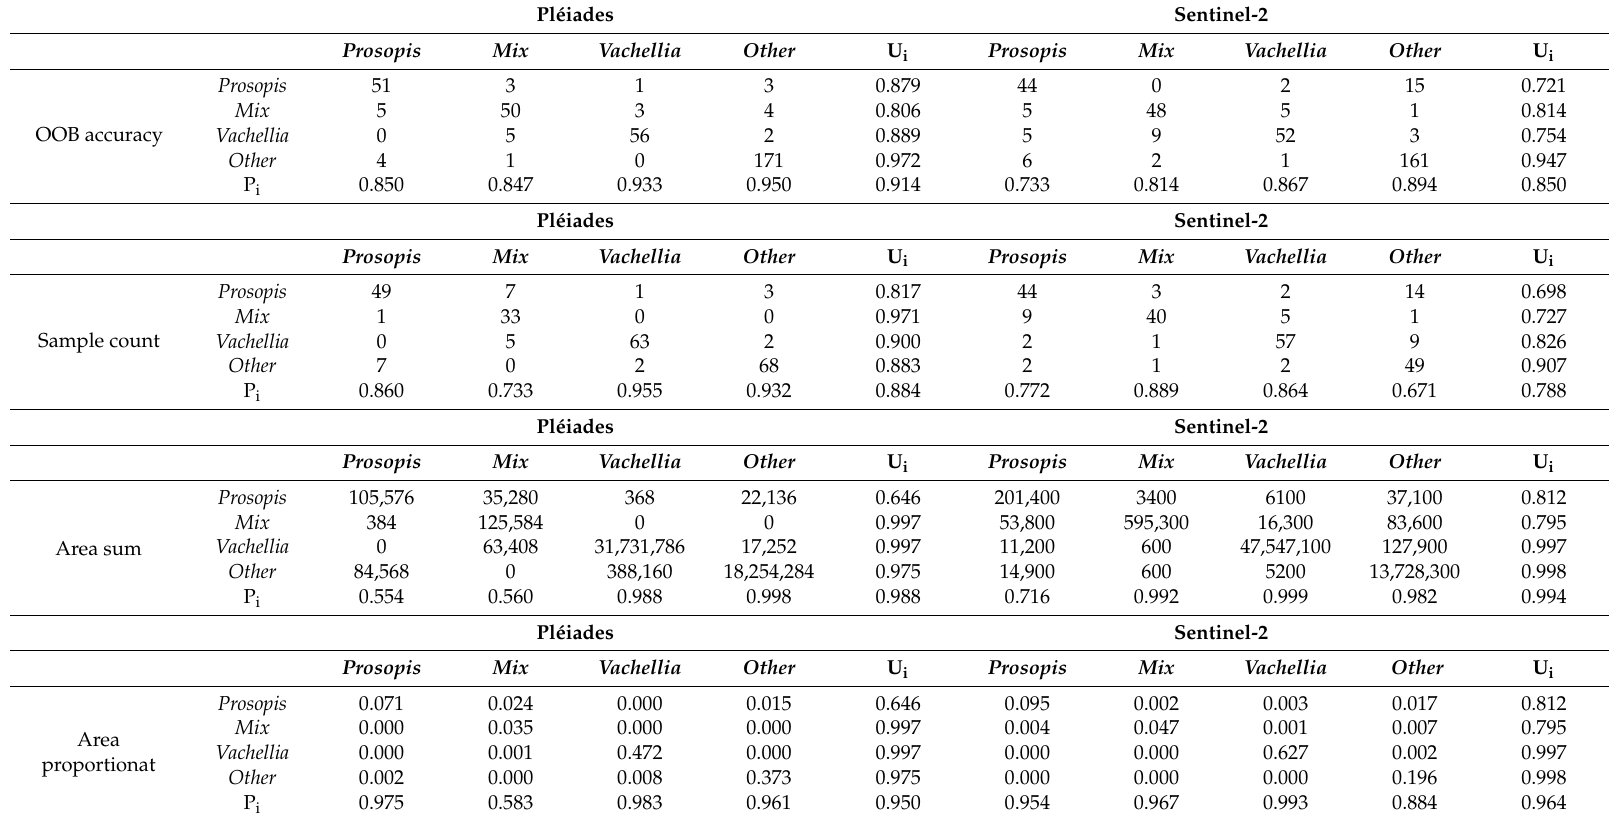
Table A2. Confusion matrices of the four-class OOB, sample count and area proportionate classifications for Pléiades and